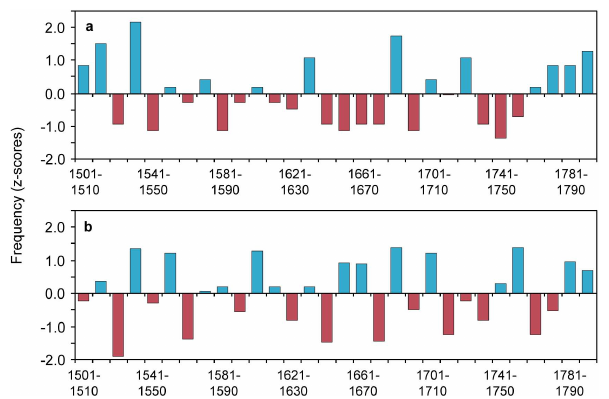
Fig. 10. Decadal frequencies of dry months in the Czech Lands (MAMJJ) (a) and decadal means of MAMJJ precipitation totals re- constructed from TRW in southern Moravia (Br´azdil et al., 2002) (b) . Both series are expressed as standardised values (z-scores) and values of precipitation totals have been inverted for easier interpre- tation (positive values in both graphs show more dry